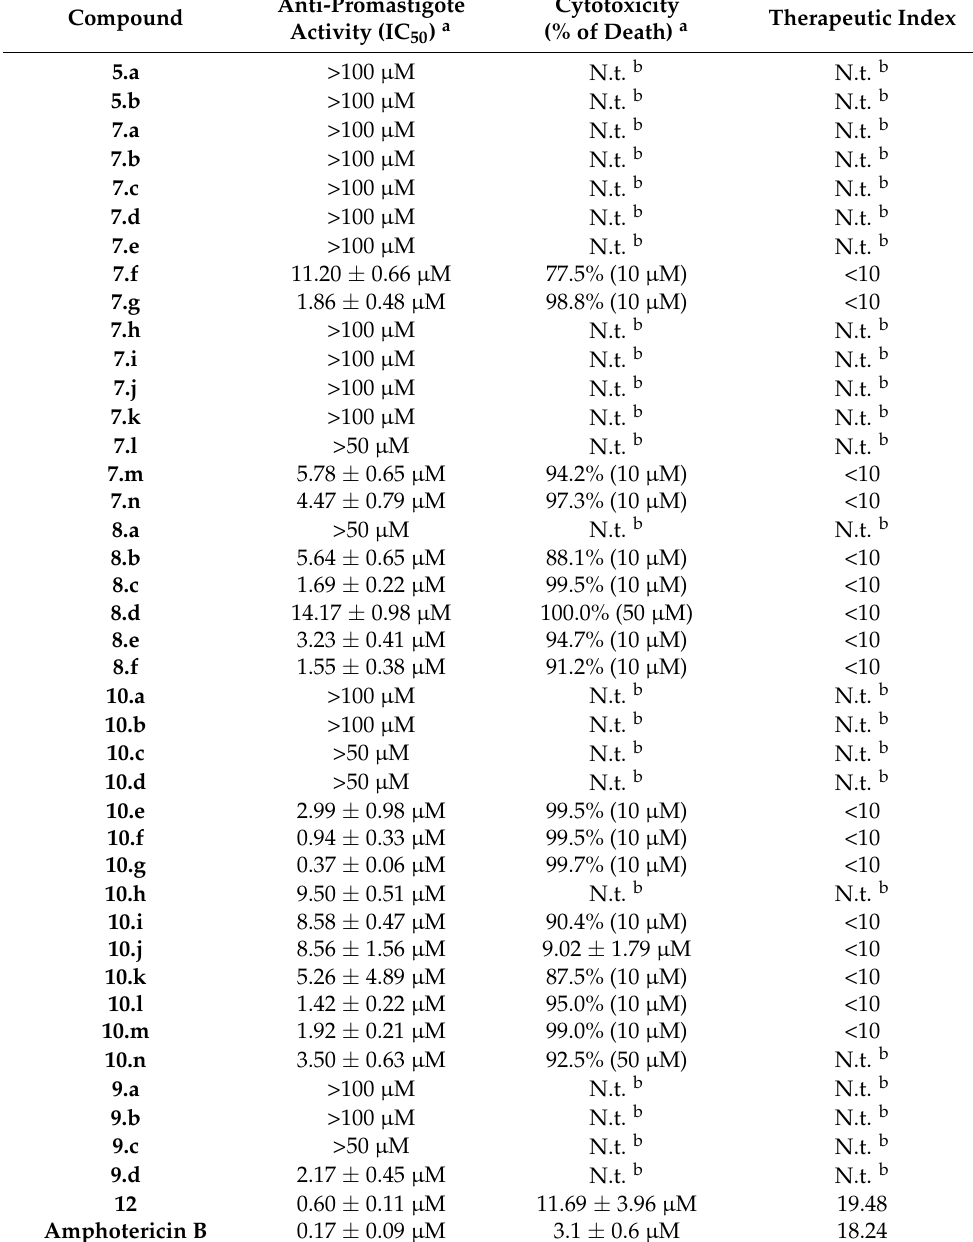
Table 1. Antileishmanial activity of 1,2,3,4-tetrahydroacridine